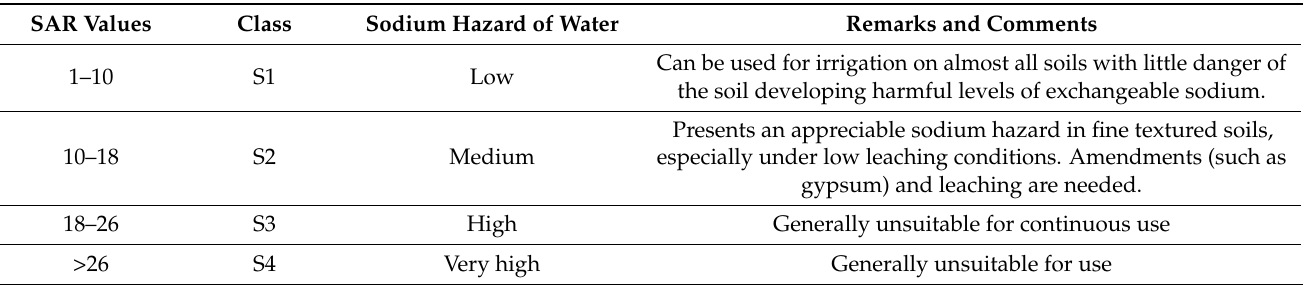
Table 6. The sodium hazard of water [1].